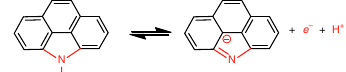
Fig. 4 Redox reaction. The redox reaction of pyrrolic nitrogen.